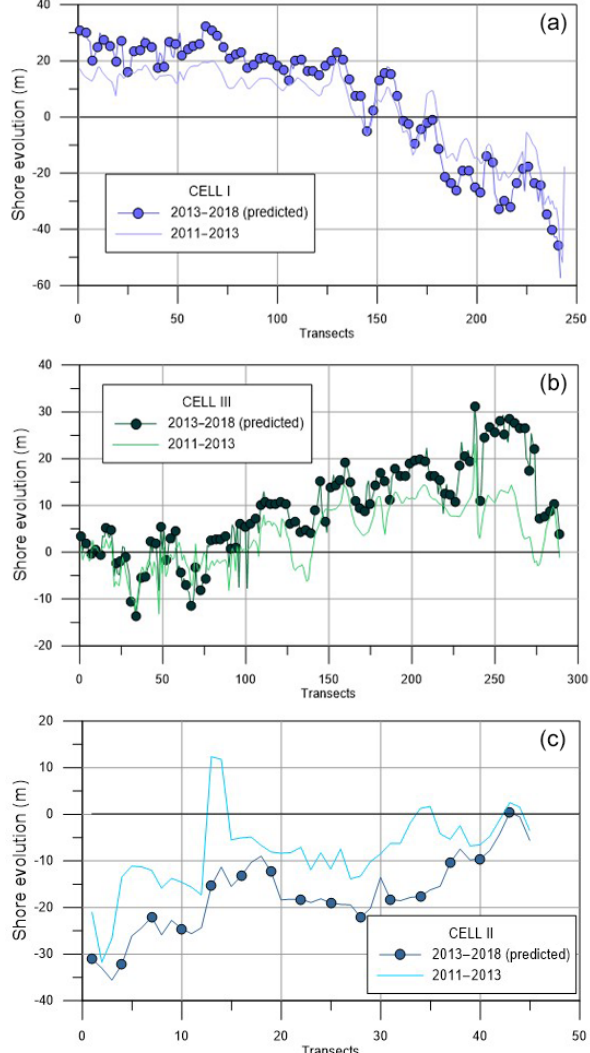
Figure 16. Observed shoreline in the period 2011–2013 and pre- dicted shoreline for the period 2013–2018 in (a) Cell I, (b) Cell II and (c) Cell